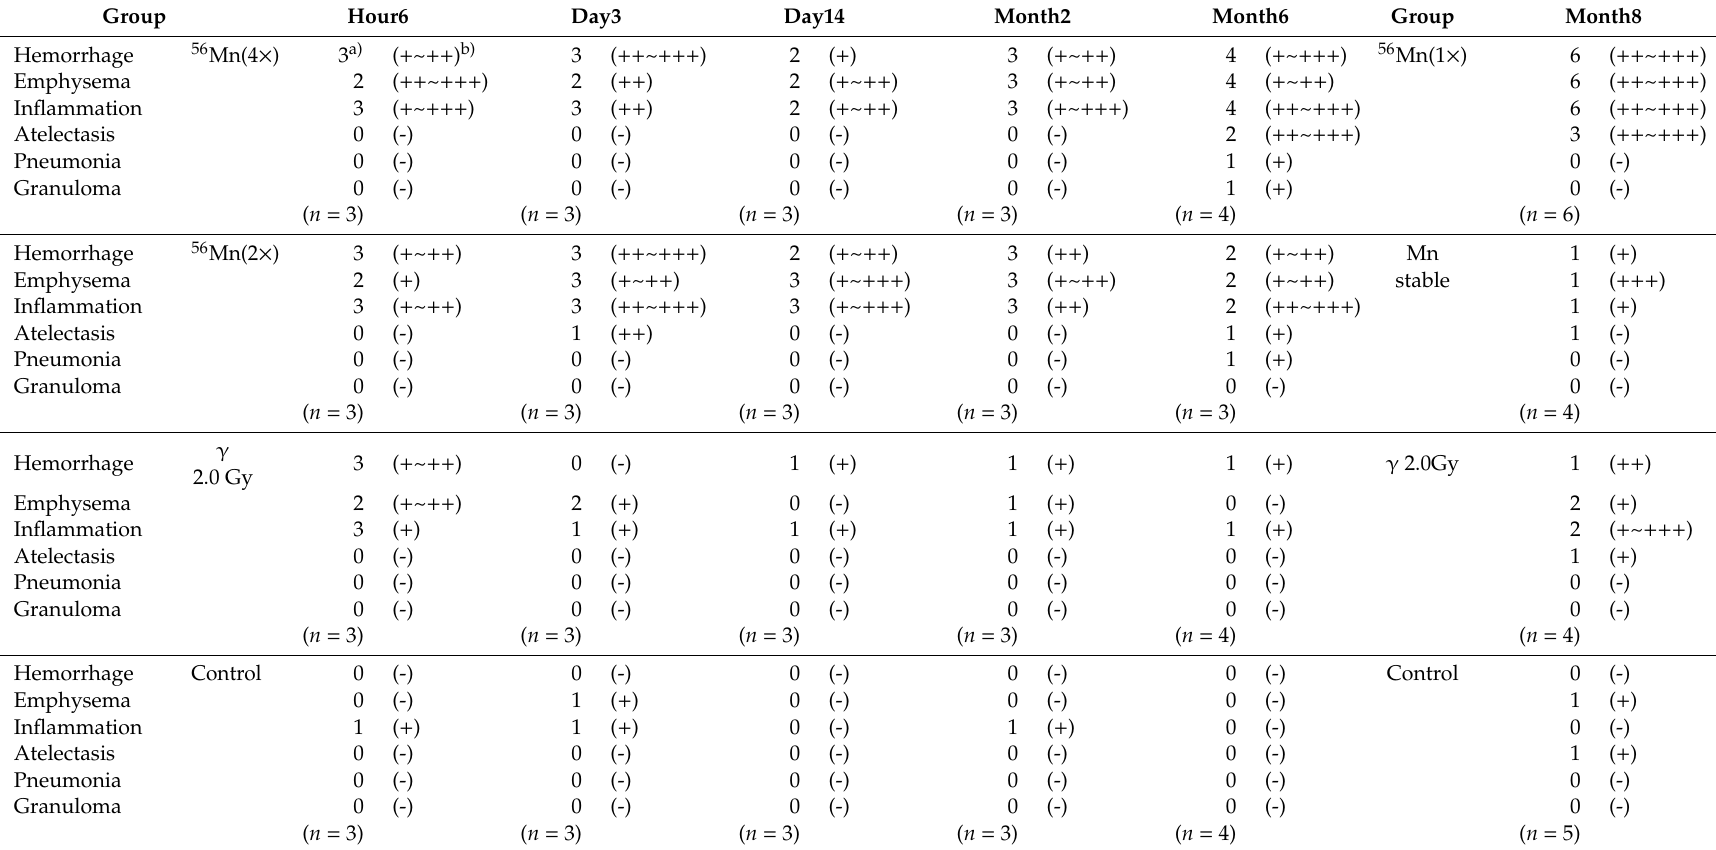
Table 2. Histological findings in the lung in rats exposed to 56 Mn and γ 2.0 Gy and control